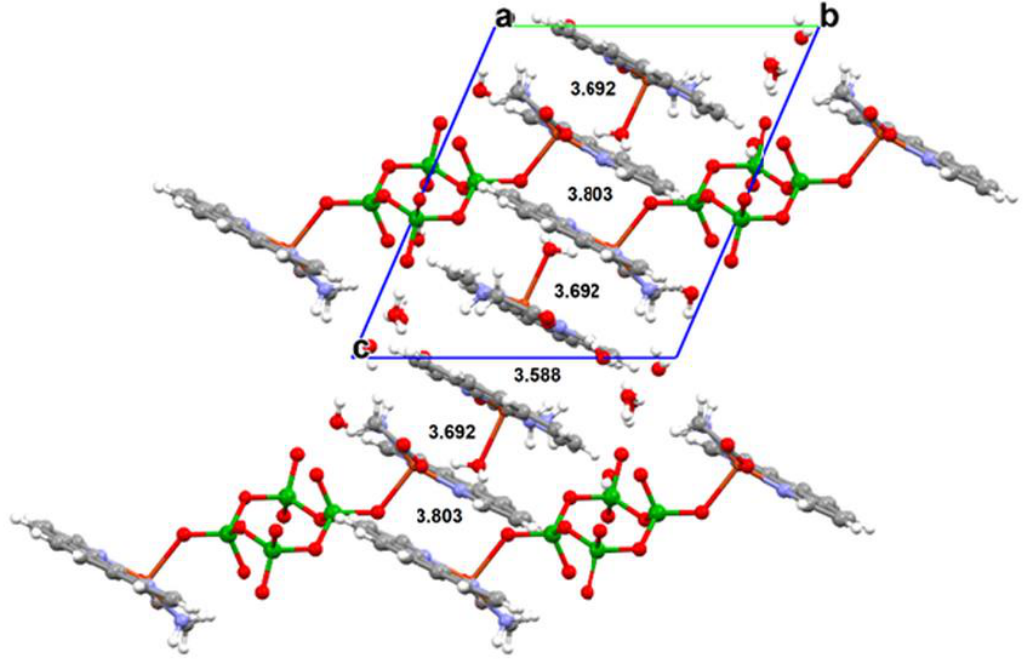
Figure 2. Ball and stick representation of the stacking of complexes in the structure of Compound 1 along with the [0,1,−1] crystallographic direction through π–π interactions.